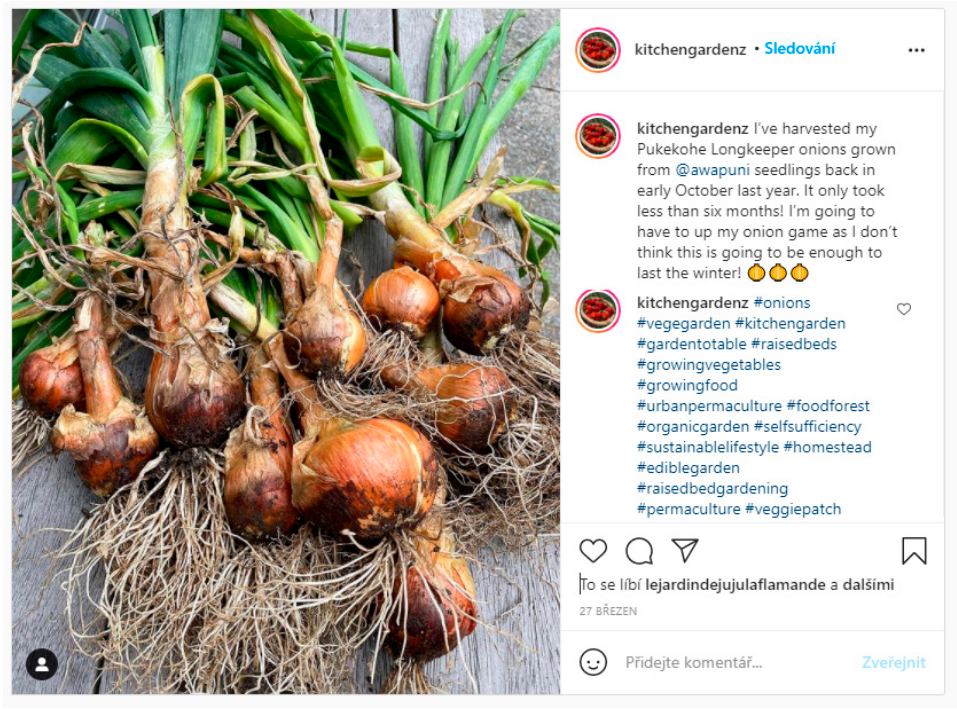
Figure 8. Example of an Instagram message with hashtags.